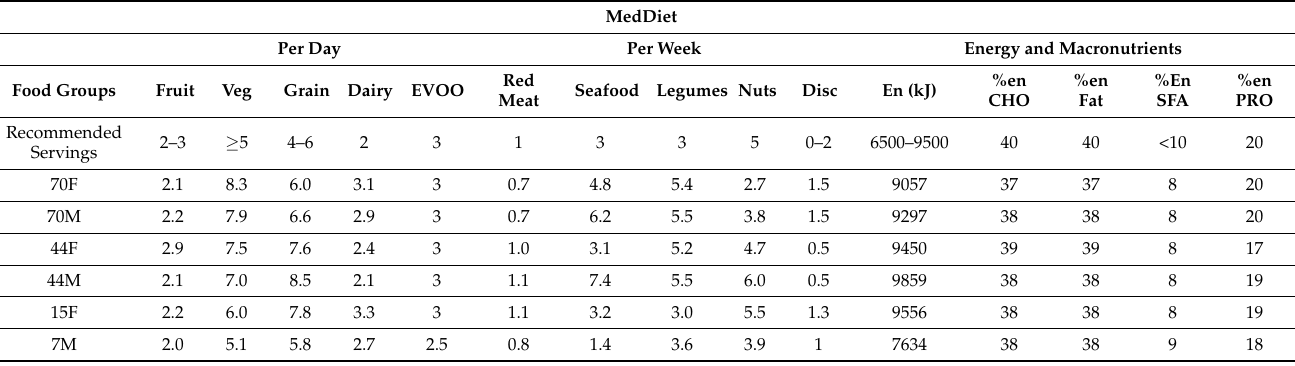
Table 5. Overview of average daily and weekly food group and discretionary intake and energy contributions for the MedDiet food